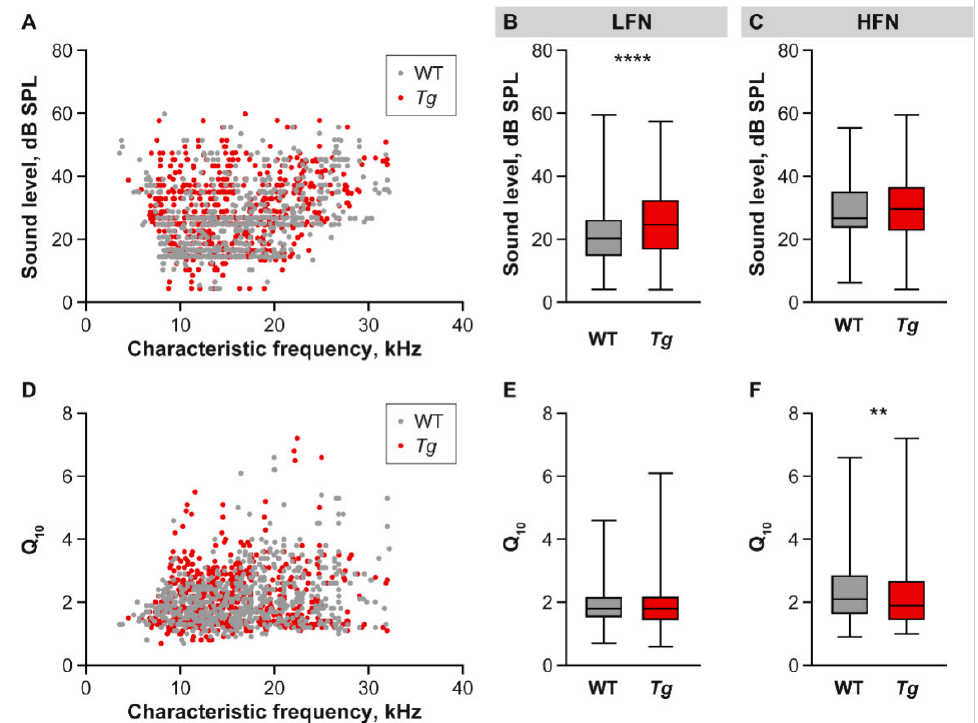
Figure 3. Characteristics of IC neuronal responses to pure tones. ( A ) Scatter plot showing thresholds of all measured neurons as a function of characteristic frequency in both groups of animals. ( B , C ) Box and whiskers plots showing distribution of neuronal thresholds separately in LFN and HFN in the WT and Tg IC. Median with interquartile range and extremes, Mann-Whitney test, **** p < 0.0001. ( D ) Scatter plot showing the quality factor of all measured IC neurons as a function of characteristic frequency in both groups of animals. ( E , F ) Box and whiskers plots showing distribution of neuronal quality factors separately in LFN and HFN. Median with interquartile range and extremes, Mann- Whitney test, ** p <